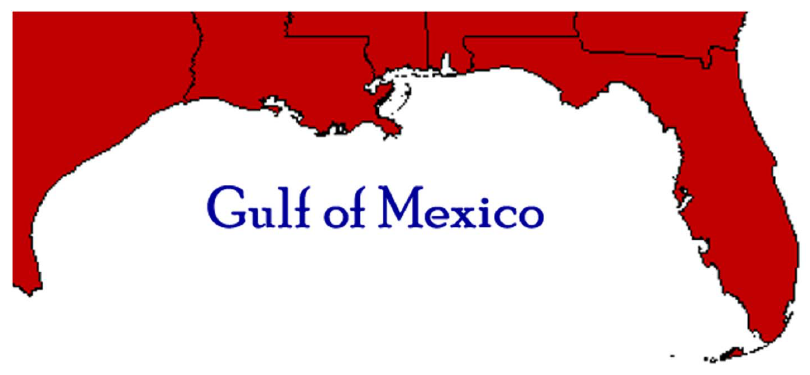
Figure 1. Gulf Coast of the US (original prepared by Nathaniel Wolf).